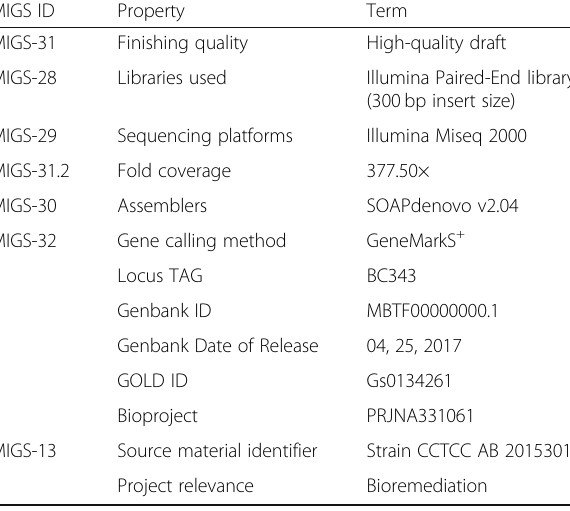
Table 2 Project information